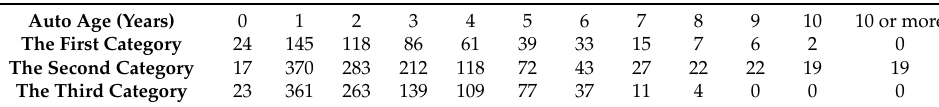
Table 2. Classification of auto age.